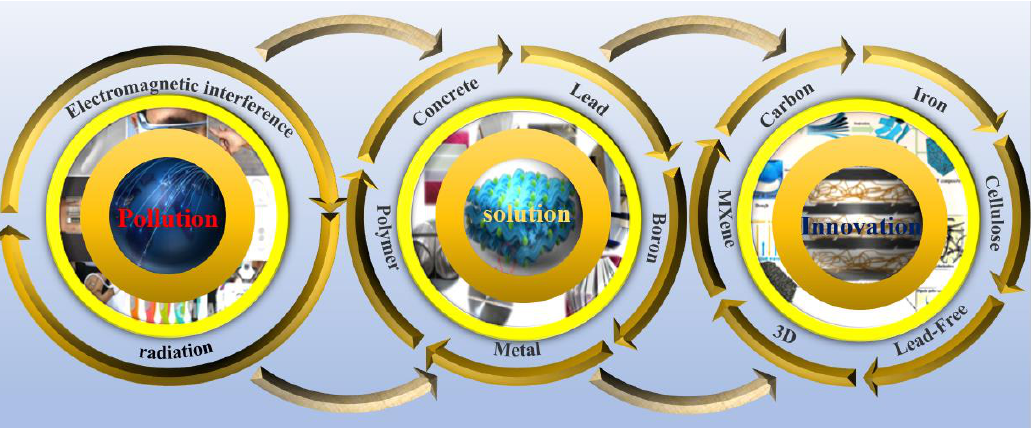
Figure 3. Technical development of membrane shielding materials to handle electromagnetic/radiation pollution.